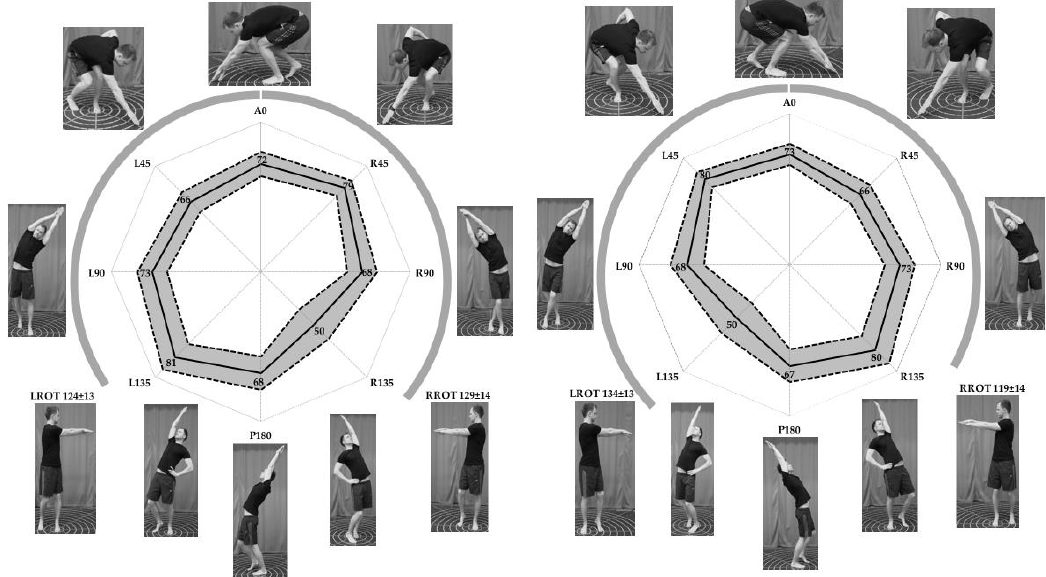
Figure 1. Horizontal and rotational reaches for left and right leg. Visual representation of all reaches (photographs). Horizontal reaches (center graphs) with average (cm, black line) and standard deviation (±SD, grey shaded area). Rotational reaches (°, circular graphs) with average (±SD). All values are based on results from four sessions.